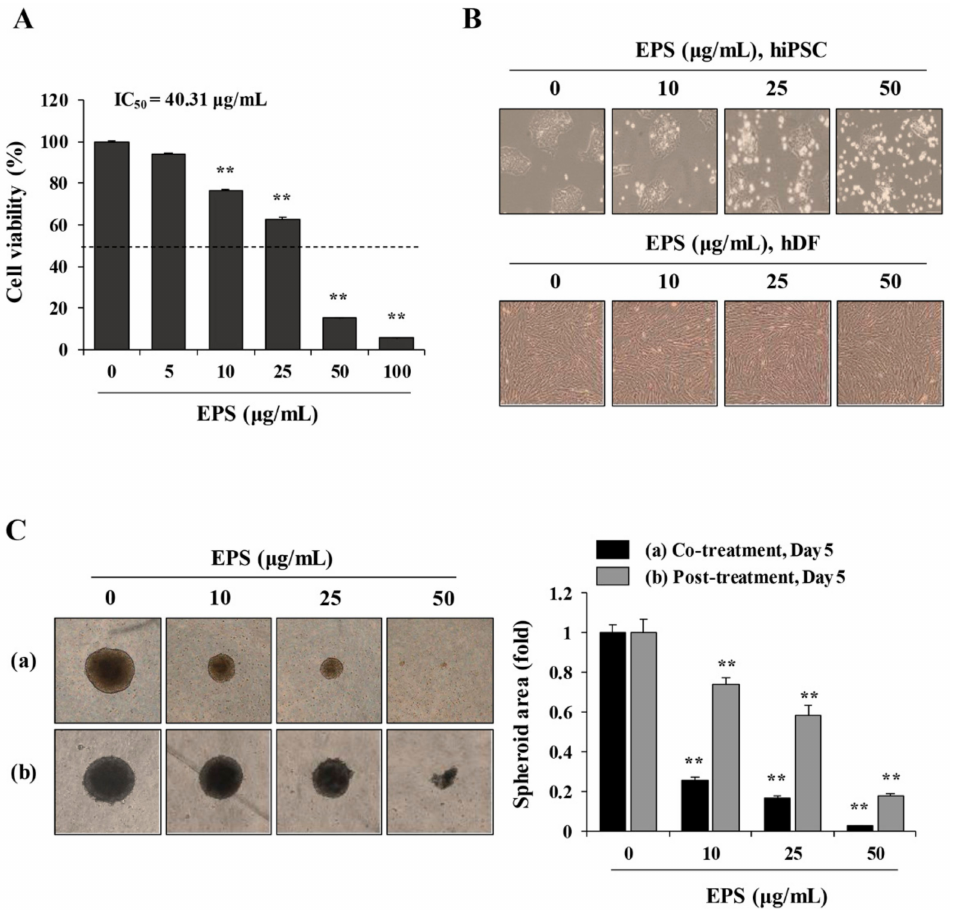
Figure 1. Ethanol extract of Prunellae Spica (EPS) induces cytotoxic e ff ect in human-induced pluripotent stem cells (hiPSCs). ( A ) hiPSCs were seeded on 24-well culture plates and treated with the indicated concentrations of EPS up to 100 µ g / mL. After 24 h, viable cells were measured using the CCK-8 assay and relative cell viability compared with EPS-untreated control hiPSCs was calculated. Data are expressed as the mean ± SD from three independent experiments. ( B ) hiPSCs and human dermal fibroblasts (hDFs) were treated with 10, 25, and 50 µ g / mL EPS for 24 h and cell morphology was observed under an inverted microscope. ( C ) hiPSC were assembled to spheroids on ultra-low attachment 96-well U-bottomed plates and incubated in the presence or absence of 10, 25, and 50 µ g / mL EPS from day 0 (a) or day 2 (b). Spheroids were photographed at day 5 post-treatment and relative spheroid area compared with EPS-untreated control hiPSCs was determined using Image J software. Data are expressed as the mean ± SD from triplicate samples. ** p < 0.01 vs. EPS-untreated